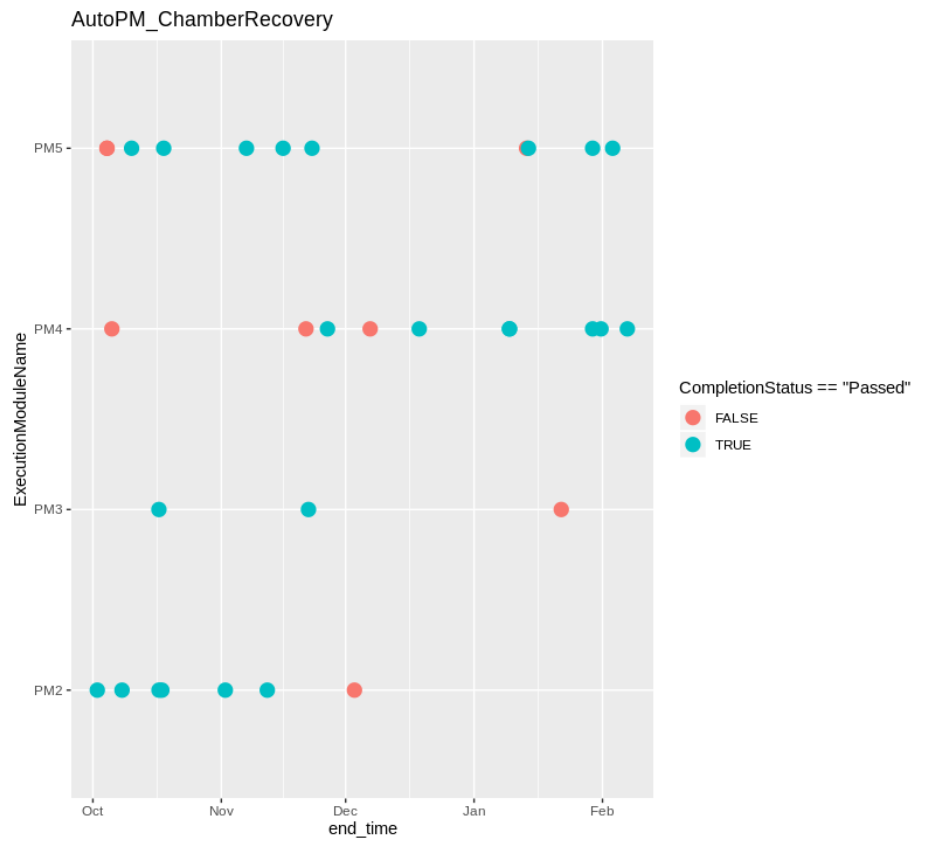
Figure 10. Success and Failure